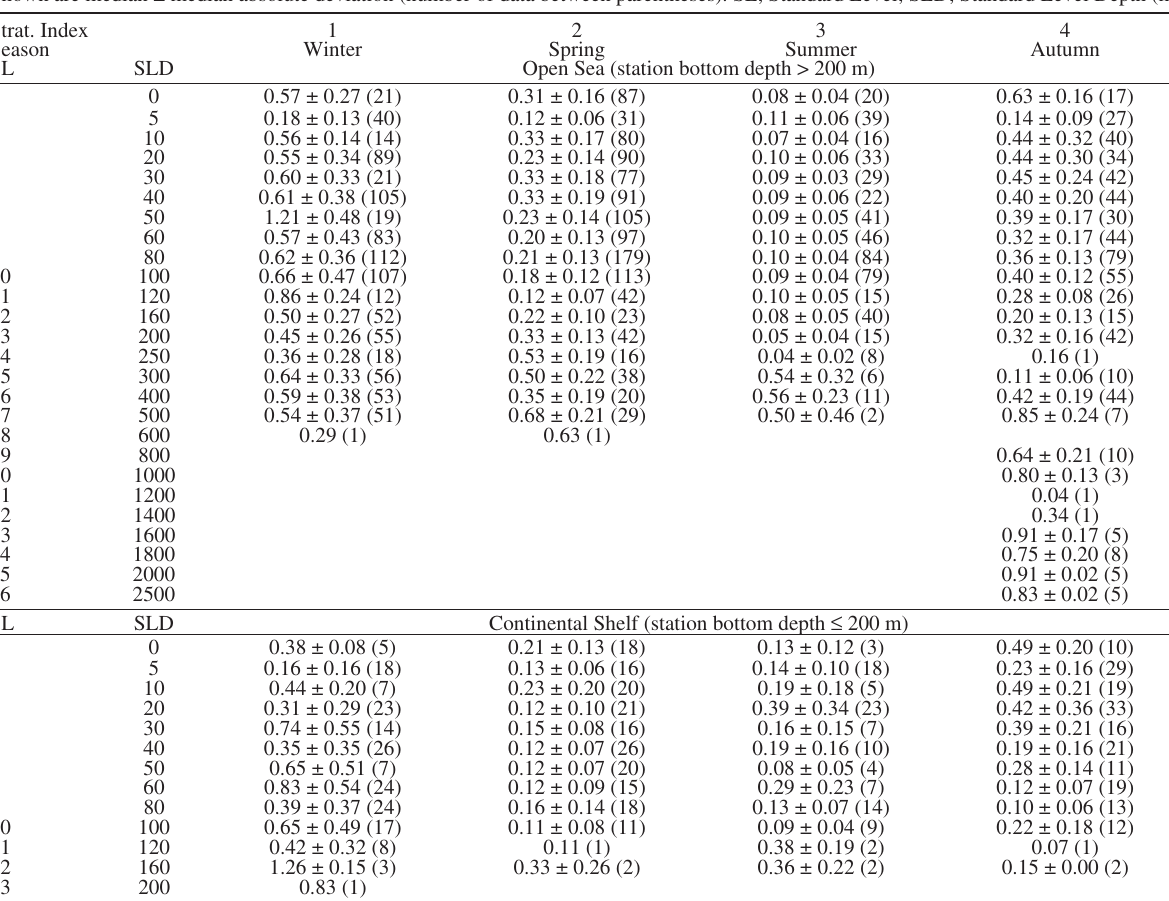
Table S5. – Ammonium concentration (μM) with depth and stratification of the water column in the Catalan Sea (NW Mediterranean Sea). Shown are median ± median absolute deviation (number of data between parentheses). SL, Standard Level; SLD, Standard Level Depth (m). Strat.